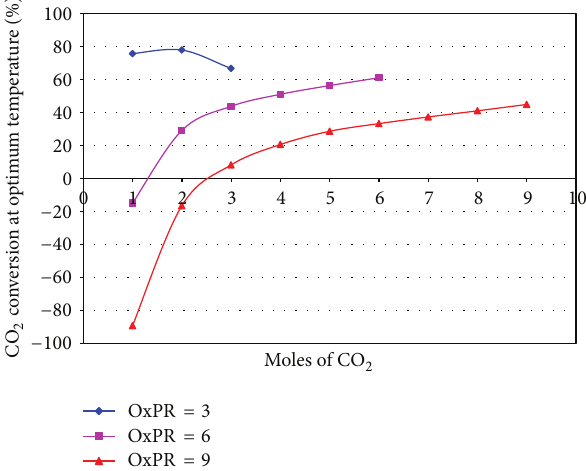
Figure 11: CO 2 conversion at optimum temperature in CR of